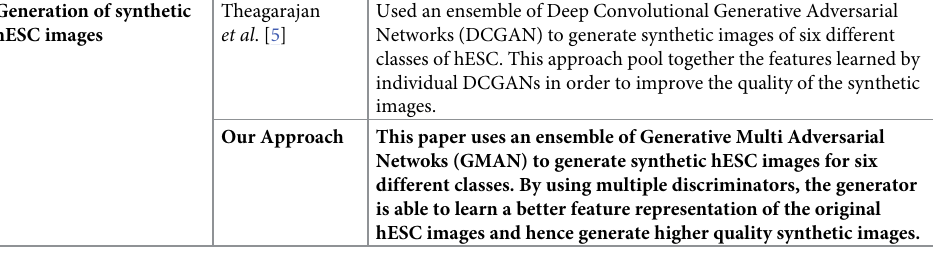
Table 3. Summary of the related work for generating synthetic hESC images and contributions of this paper. Generation of synthetic hESC